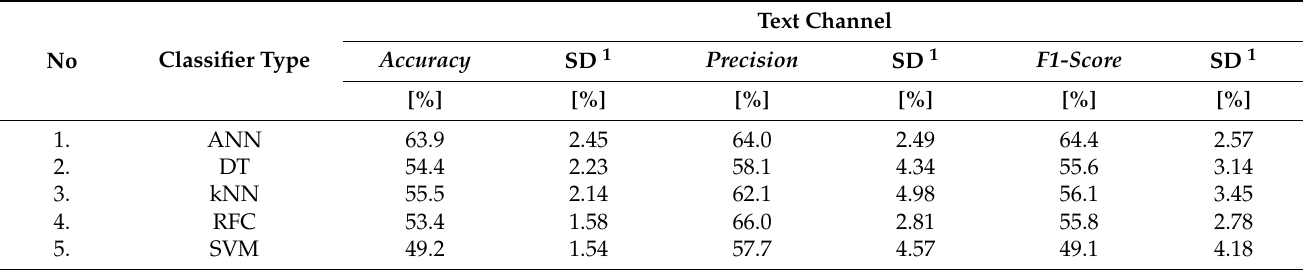
Table 5. Effectiveness of automatic detection of affective states in text channels.